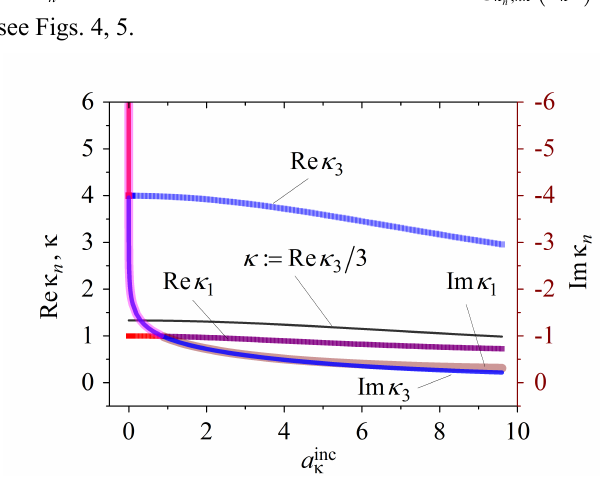
algorithm (9) in the amplitude range Figure 5: The curve of the excitation frequencies and the curves of the spectral characteristics for .